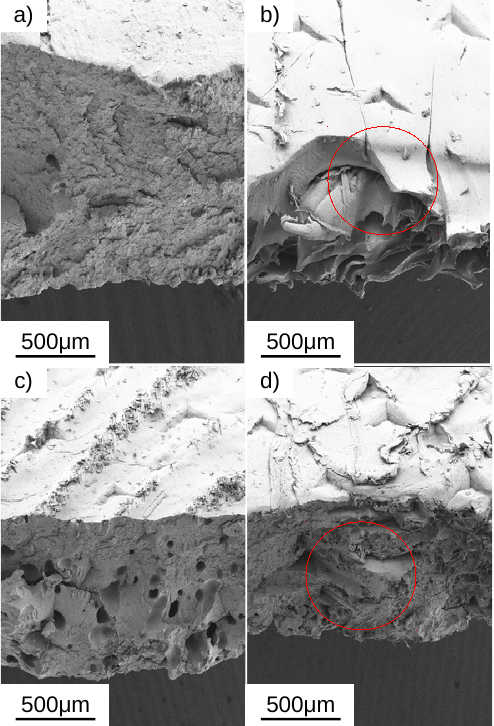
Figure 8. SEM micrographs of representative tensile specimens 3D printed with a [45°, 135°] infill direction: ( a ) LCR pristine PVDF, ( b ) HCR pristine PVDF, ( c ) LCR of 10% ZnO-PVDF, and ( d ) HCR of 10% ZnO-PVDF. The red circles shows elongation characteristic of the ductile failure of the HCR